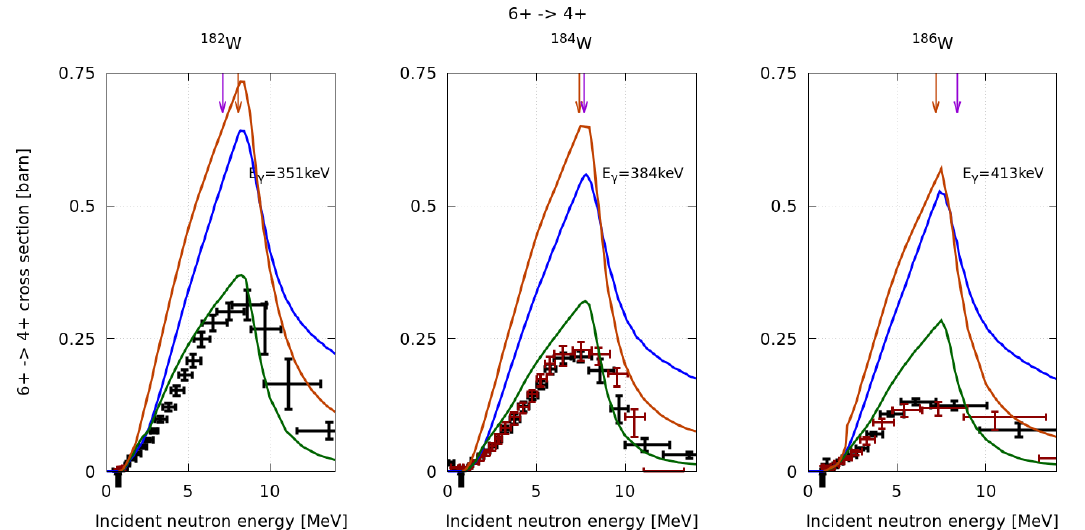
Figure 3. Same as figure 1, for the 6 + to 4 + transition in the ground state band. No data for 182 W could be extracted from the nat W dataset.